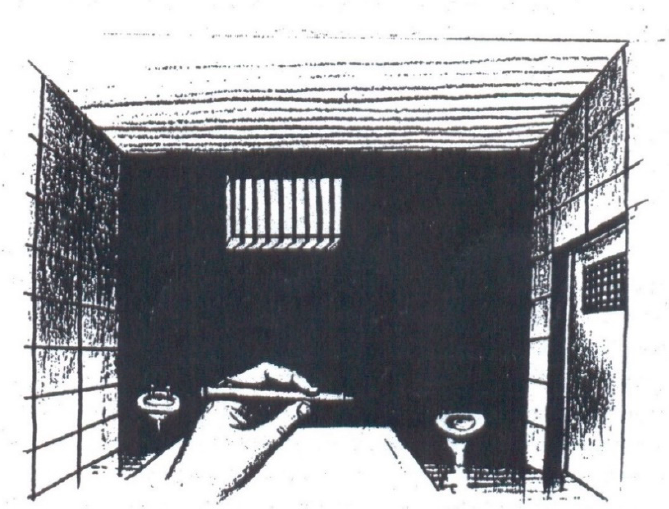
Figure 3. A First-Person Sketch of Being “in” a Jail Cell With its Missing Back Wall (Harding [1992] 2002, p. 17). Reproduced with Permission from the Shollond Trust.